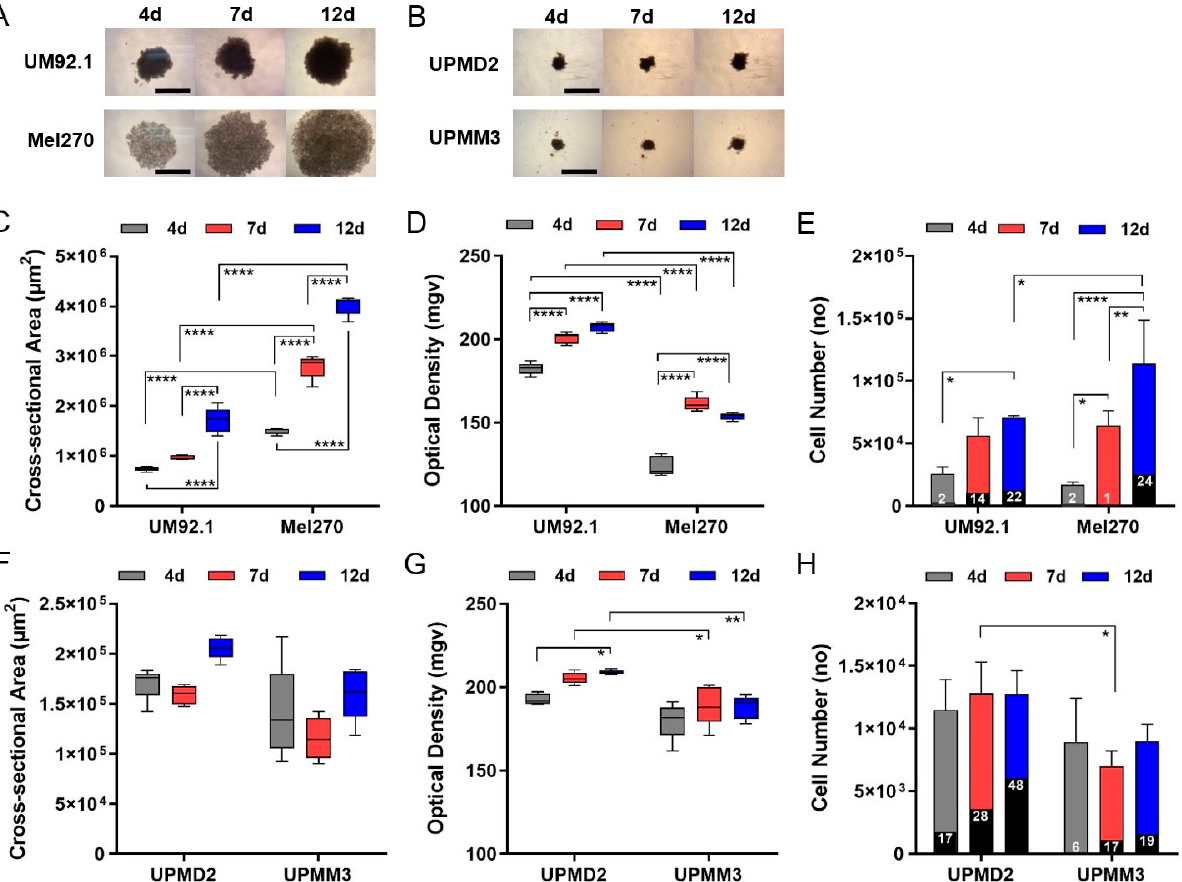
Figure 1. Generation of 3D tumor spheroids from UM and UPM cell lines. UM or UPM cells were seeded at 5000 cells per well. ( A ) Spheroids generated from UM cell lines UM92.1 and Mel270. Representative images are shown at day 4, 7 and 12 (4 × magnification; scale bar of figure 1A represents 1000 µm). ( B ) Spheroids generated from UPM cell lines UPMD2 and UPMM3. Representative images are shown at day 4, 7 and 12 (4 × magnification; scale bar of figure 1B represents 1000 µm). ( C , F ) Spheroid cross-sectional area (µm 2 ) and ( D , G ) optical density (mgv, mean grey value) were determined ( n = 5 each time point). ( E ) UM spheroids or ( H ) UPM spheroids were trypsinized, stained with trypan blue and live/dead cell numbers were counted at day 4, 7 and 12. Dead cells are indicated by black columns; % of dead cells is given. A statistical analysis was performed using a two-way ANOVA and Tukey’s multiple comparisons test; significance levels are indicated * p < 0.05, ** p < 0.01, **** p < 0.001.